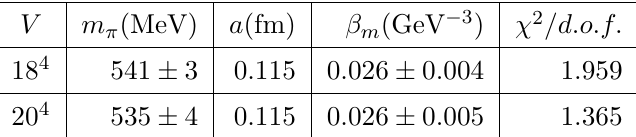
Table 7. The magnetic dipole polarizability of the charged (cid:26) meson obtained for the lattice spacing 0 : 115 fm and the lattice volumes 18 4 , 20 4 from the (cid:12)t (5.1). The pion masses are represented in the second column, the values of (cid:31) 2 =d:o:f are shown in the last